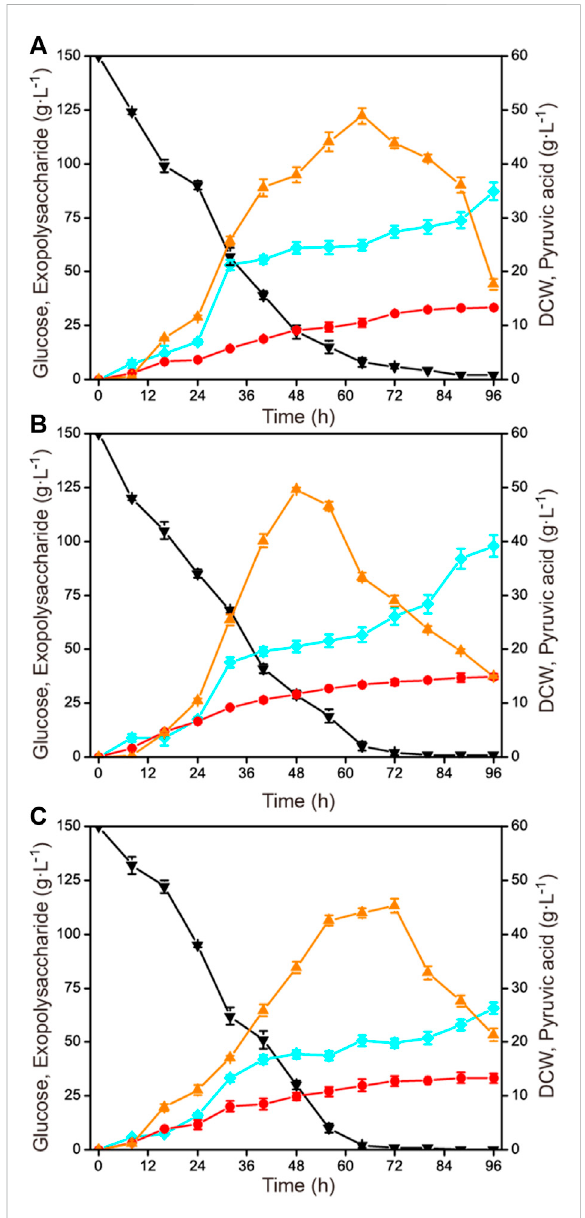
Time courses of exopolysaccharide production at different aeration rates in a 1-L fermenter. (A) 600 rmin − 1 and 0.5 vvm. (B) 600 min − 1 and 1.0 vvm. (C) 600 rmin − 1 and 1.5 vvm. Black down triangles, glucose; orange up triangles, pyruvic acid; red circles, DCW; blue squares, exopolysaccharide.